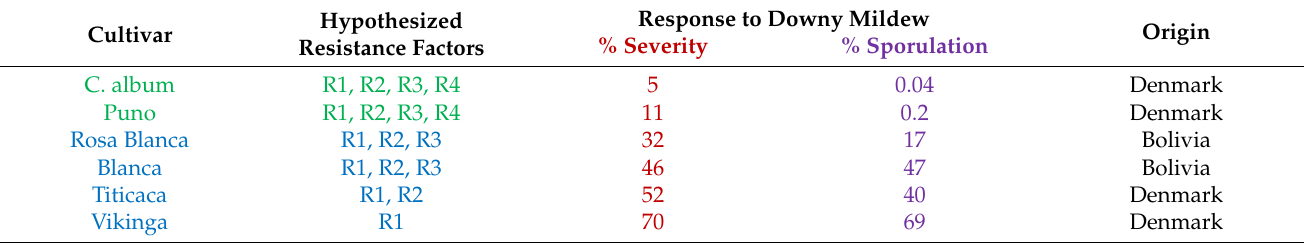
Table 4. Set of quinoa cultivars and Chenopodium album postulated for profiling the virulence of Peronospora variabilis.